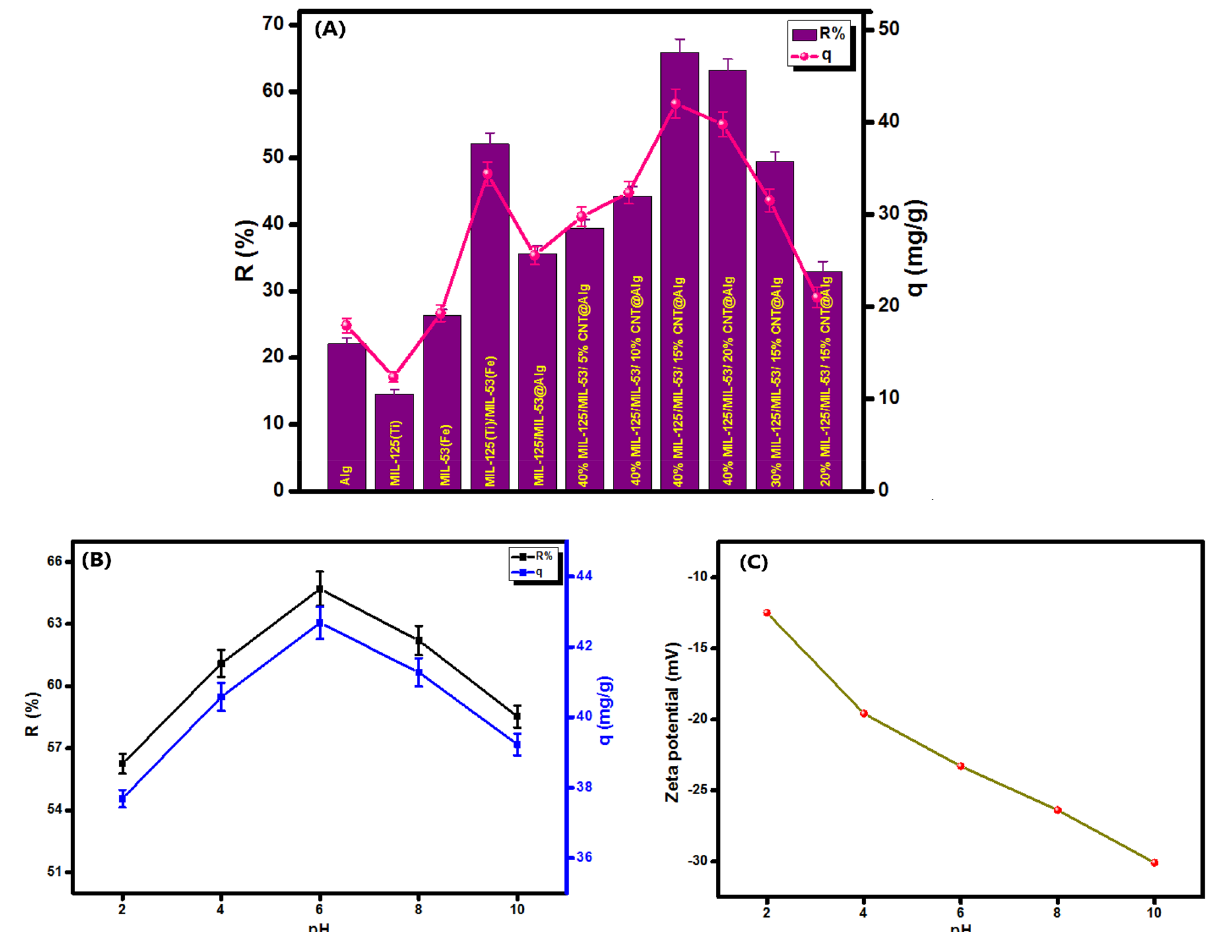
Figure 7. ( A ) Effect of CNT and MIL-125(Ti)/MIL-53(Fe) proportions and ( B ) Effect of pH, Effect of dosage on the removal efficacy and adsorption capacity of MIL-125(Ti)/MIL-53(Fe)/CNT@Alg composite microbeads and ( C ) zeta potential versus pH for MIL-125(Ti)/MIL-53(Fe)/CNT@Alg composite